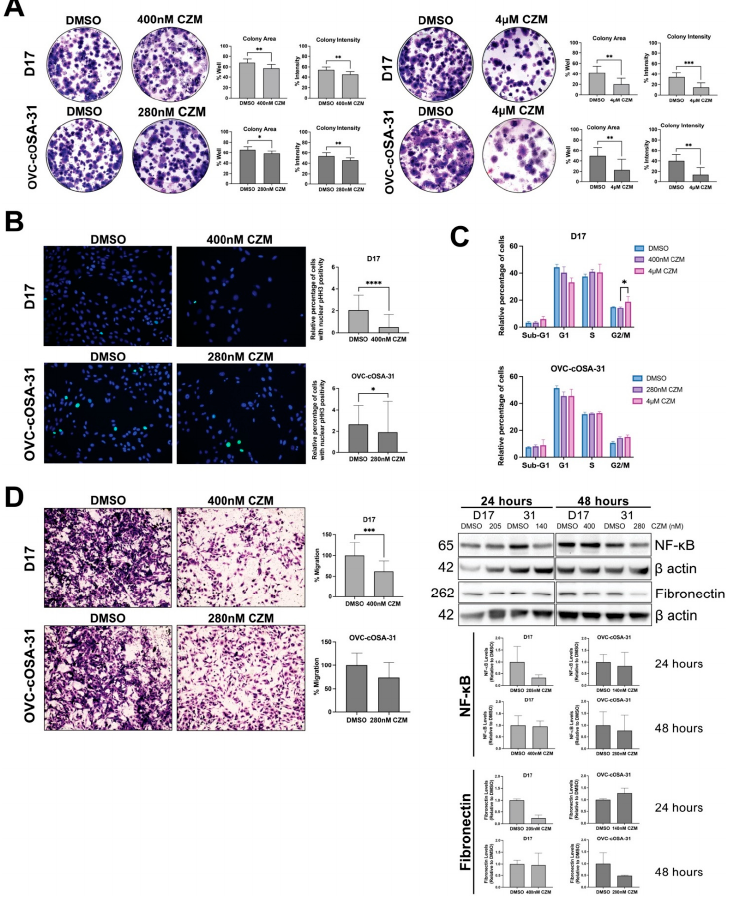
Figure 5. Capzimin reduces clonogenic survival, cell growth, and migration. ( A ) CZM reduces the clonogenic survival in both D17 and OVC-cOSA-31 cell lines at their respective IC 50 dose (left) and the 4 μ M dose (right). Colony area is defined as the area of the well occupied by cells, while colony intensity is defined as the pixel intensity of the colony. Graph depicts mean ± SD from n = 3 independent experiments, each experiment was seeded in 3 technical triplicates; * indicates p < 0.05, ** indicates p < 0.01, *** indicates p < 0.001 as determined by the Mann-Whitney test. ( B ) CZM reduces the percentage of mitotically active cells. Immunolabelling and quantification of DMSO or CZM-treated cells show differences in the nuclear levels of mitotic marker phosphorylated histone-H3 (pHH3). Graphs depict the relative nuclear positivity of pHH3 from n = 4 experiments, 5 images were evaluated per experiment; * indicates p < 0.05, **** indicates p < 0.0001. ( C ) CZM induces a G2/M arrest in D17 cells upon 4 µ M treatment for 24 h. Graph depicts mean ± SD from n = 3 independent experiments ( D ) CZM decreases migration (left) and the expression of migration-associated markers (right). Images of a transwell insert stained with crystal violet 24 h post CZM or DMSO treatment at 10X magnification. Graphs show the percentage of migrated cells as determined after extracting stained transwell inserts with 10% acetic acid and measuring the absorbance at 590nm. The extracted dye was blank corrected to a media only stained insert and normalized to the DMSO control from n = 4 experiments, 2 technical replicates per treatment group; *** indicates p < 0.001. Representative immunoblots showing the impact of CZM treatment on NF- κ B and fibronectin expression from one representative experiment. Protein levels were normalized to β actin (loading control) and compared to the DMSO control group to determine relative differences. Densitometry graph shows mean ± SD from n = 2 independent